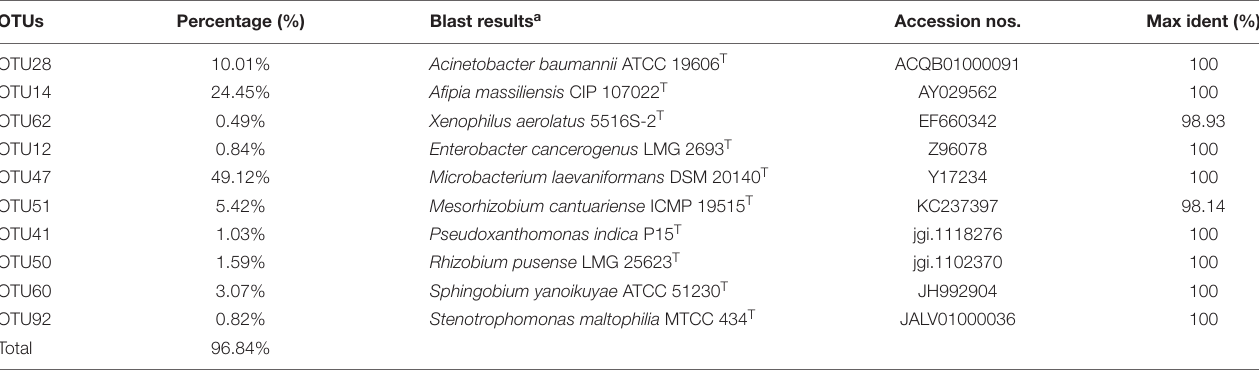
TABLE 2 | BLAST results of the dominant OTUs from consortium